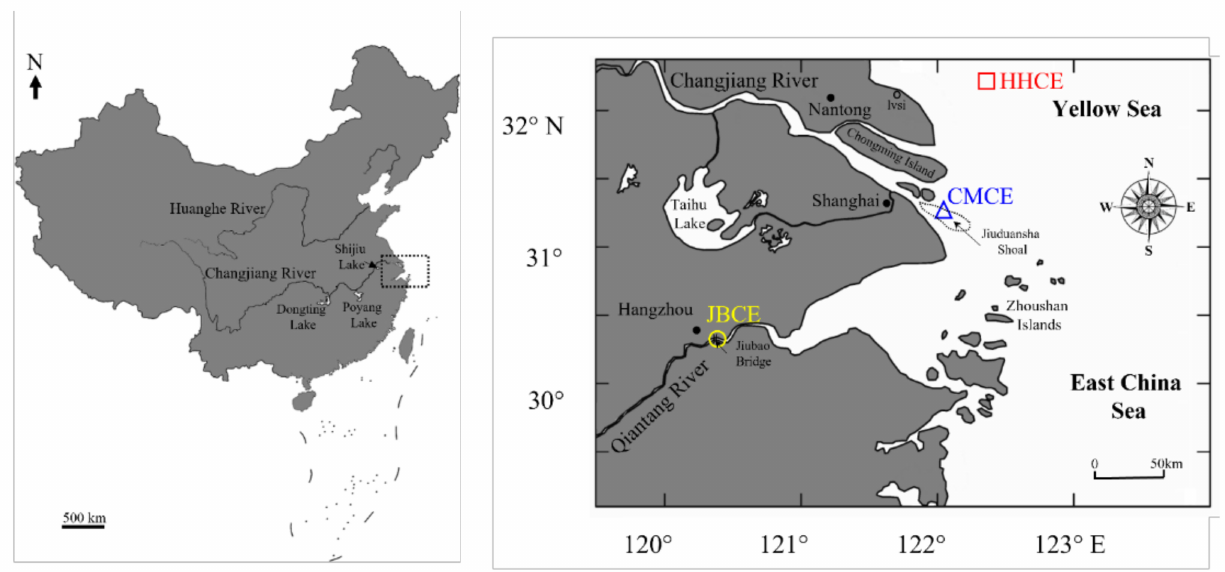
Figure 1. Sampling sites for Coilia nasus. Different markers indicate sampling sites in the Nantong coastal area of the Yellow Sea (HHCE, red square), the Changjiang estuary near the Jiuduansha Shoal (CMCE, blue triangle), and the Jiubao bridge waters in the Qiantang estuary (JBCE, yellow circle), from north to